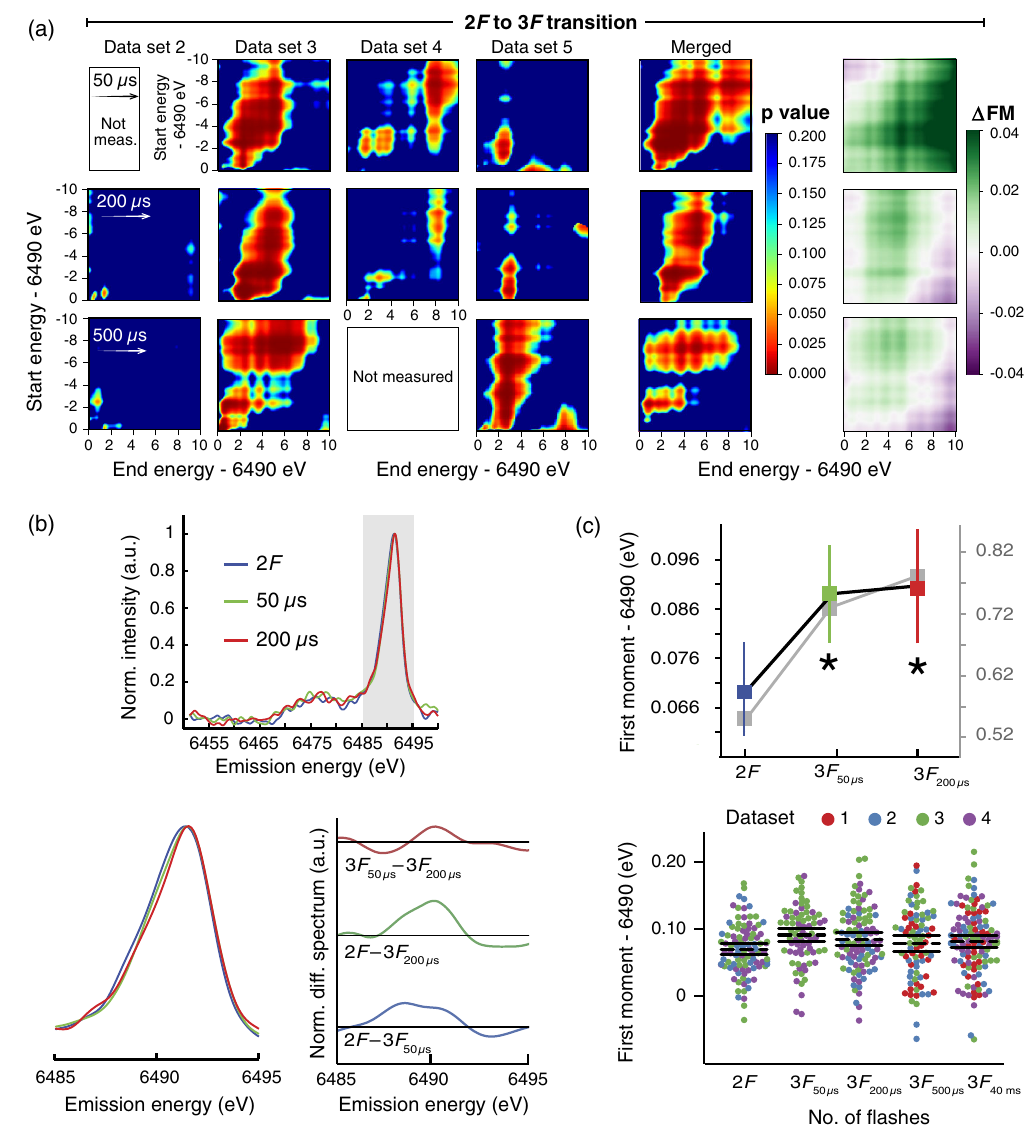
FIG. 3. Rapid onset of spectral changes observed during the S 3 -to- S 0 transition. (a) Spectral shifts occurring as a result of the 2 F → 3 F transition are characterized using 2D heat maps colored by p value (see Table S2 [5] for n ), for changes to first moments calculated over the ranges defined by the x and y axes, i.e., start and end energy, respectively. Strong contours are consistently observed, indicative of a statisticallysignificantspectralchange.Thedirectionalityandmagnitudeofspectralshiftsoccurringwiththesetransitions are also shownas − FM 2D heat maps, which graphically illustrate the change in first moments ( Δ FM ¼ FM ) calculated over the ranges defined postflash preflash by the x and y axes. All 2 F → 3 F comparisons yield primarily positive, or reductive, shifts. Determined p values of approximately 0.02 (TableIII)forthe 200 μ s timepointarefurthersupportedbytheaboveheatmaps;however,littleinformationcanbegleanedfromtheseplots of data set 2, likely due to much lower x-ray shot count; see Table II. Although the 500 μ s time point is equally compelling, the traditional energy range (6.485 – 6.495 keV) selected for reporting first moments does not deliver statistical significance (Table III). (b) Wavelet transform smoothed and background-subtracted emission spectra for merged 2 F , 3 F 50 μ , and 3 F 200 μ data, calculated as in Fig. 2(b). s s (c) (Top) Average first moments from unprocessed (color) and processed (gray) spectra. Errors are presented as SEM with n given in Table III.Thosemomentswitha statisticallysignificantdifference( p < 0 . 05 )from 2 F dataareindicatedwithanasterisk.(Bottom)Dotplot of first moments from raw data, presented as in Fig. 2(c). See Fig. S3 [5] for 2D plots of the 40 ms (majority S 0 state) time